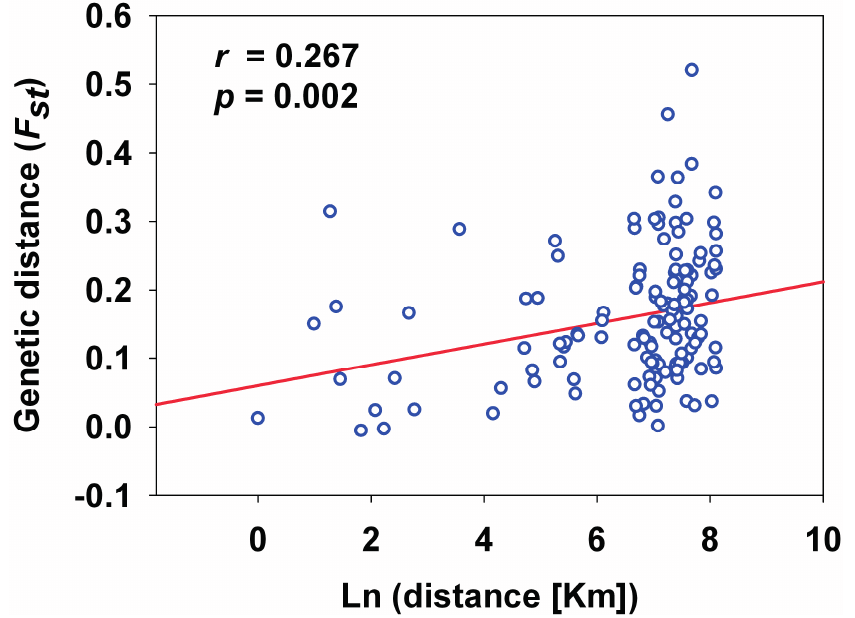
Figure 1. Relationship between genetic distance and log of geographical distance for Trialeurodes vaporariorum . The red line represents the regression line and blue circles represent the logarithm transformation of